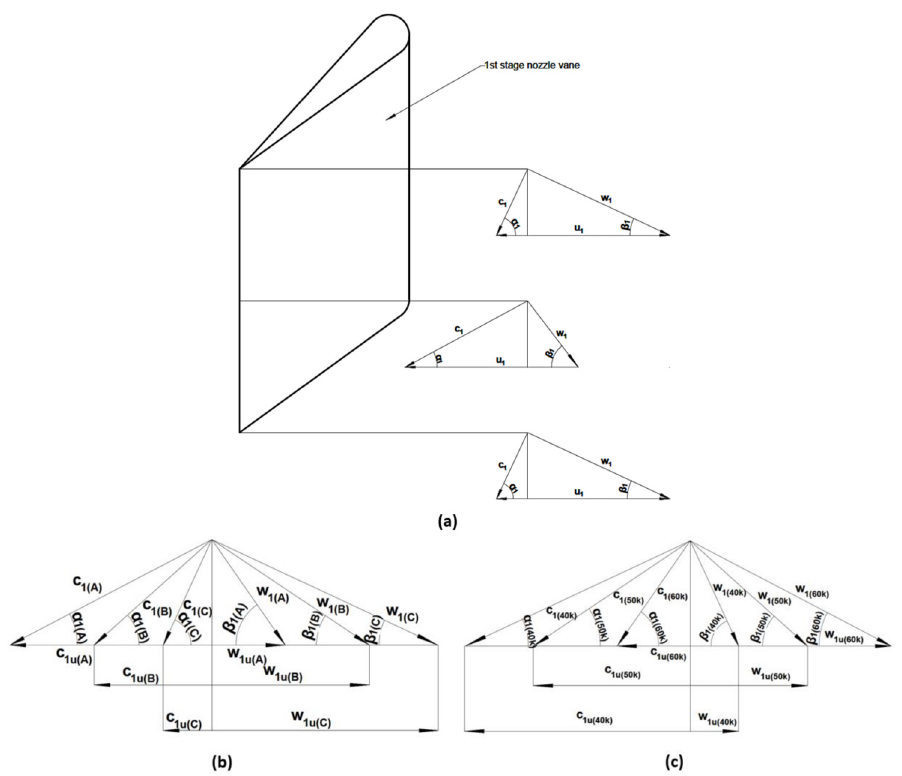
Figure 33. ( a ) The configuration of the outlet velocity triangles at the against the height of the 1st stage nozzle vane, the comparison of the velocity triangles at the outlet of the 1st stage nozzle vane at: ( b ) points A, B, and C, ( c ) at three different turbine